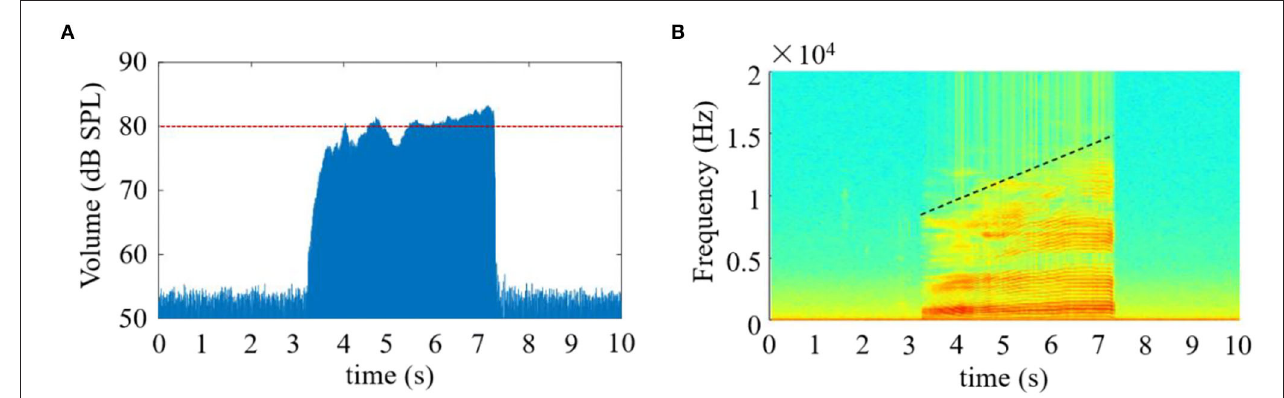
FIGURE 2 | The amplitude and spectrogram of the speech signals when phonating the vowel [a:] with continuously increasing pitch. (A) The amplitude of the speech signal as a function of time; (B) The time-frequency spectrogram of the speech signal.